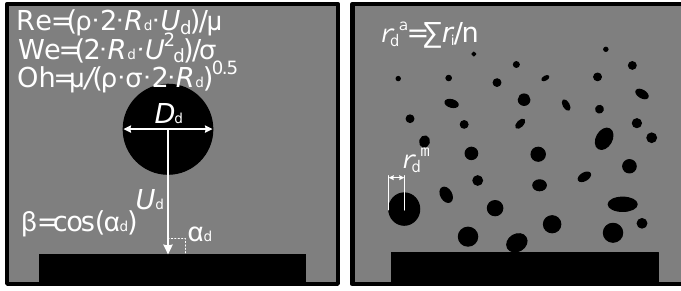
Figure 1. Diagram of the drop impingement and the main recorded and calculated parameters.